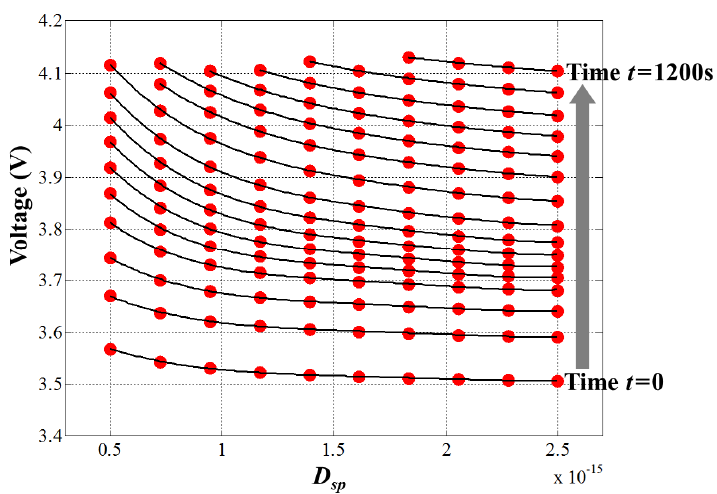
Figure 8. Output voltage with respect to input variable D sp for various time intervals. The red dot represents the voltage V ki at D sp and interval t k;i as obtained from the P2D model; the solid black line represents the voltage curve V k ( D sp ) obtained using fourth-order polynomials in the